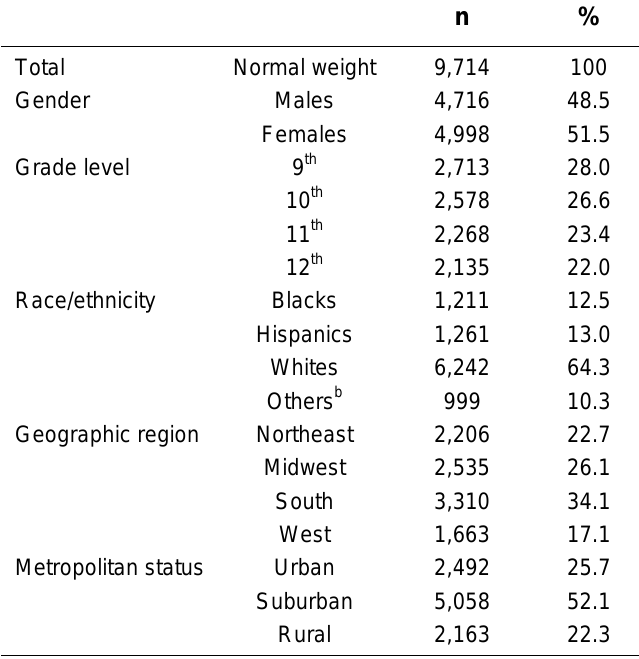
Descriptive Characteristics of Normal Weight